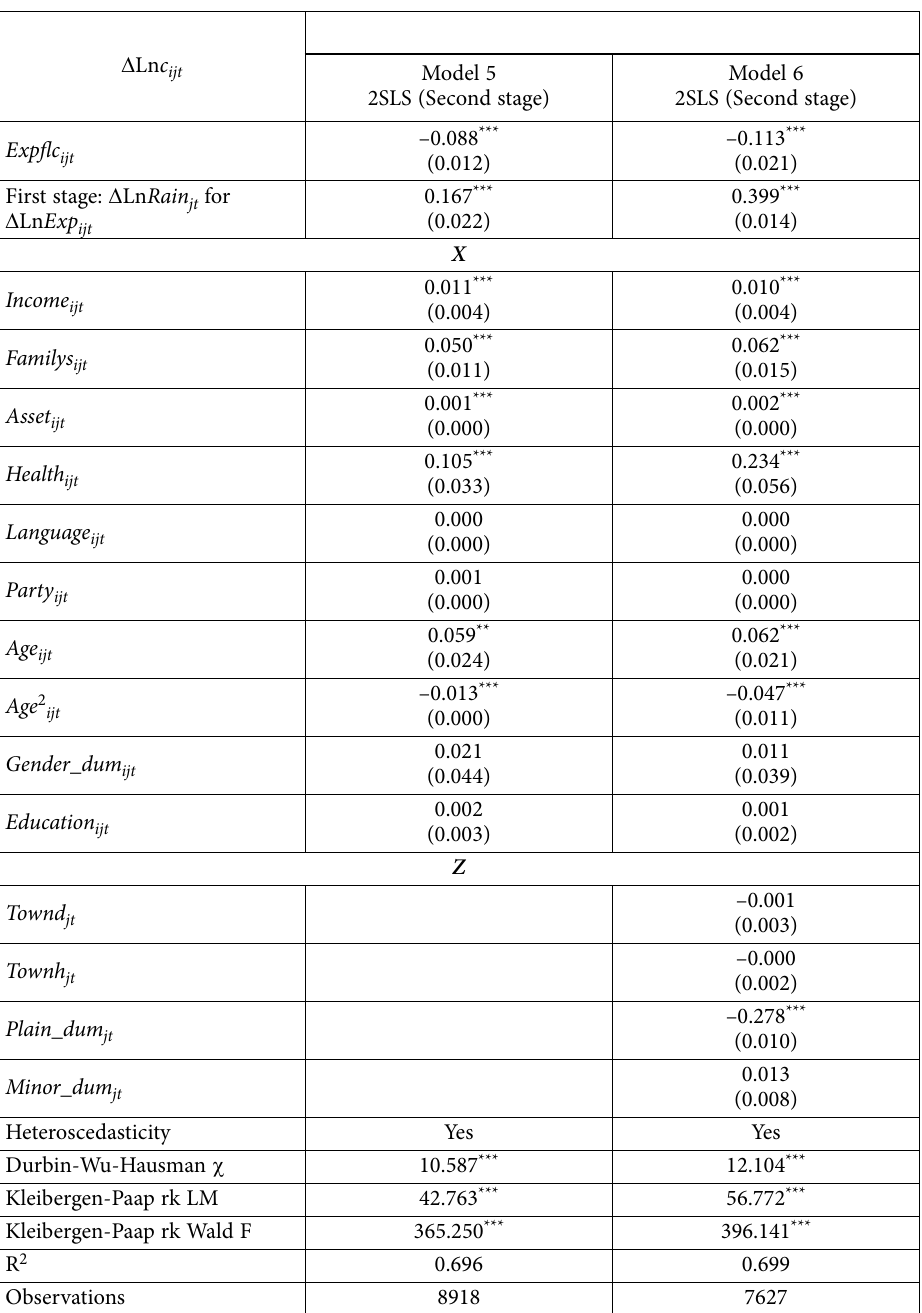
Table 5. Estimation results of instrumental